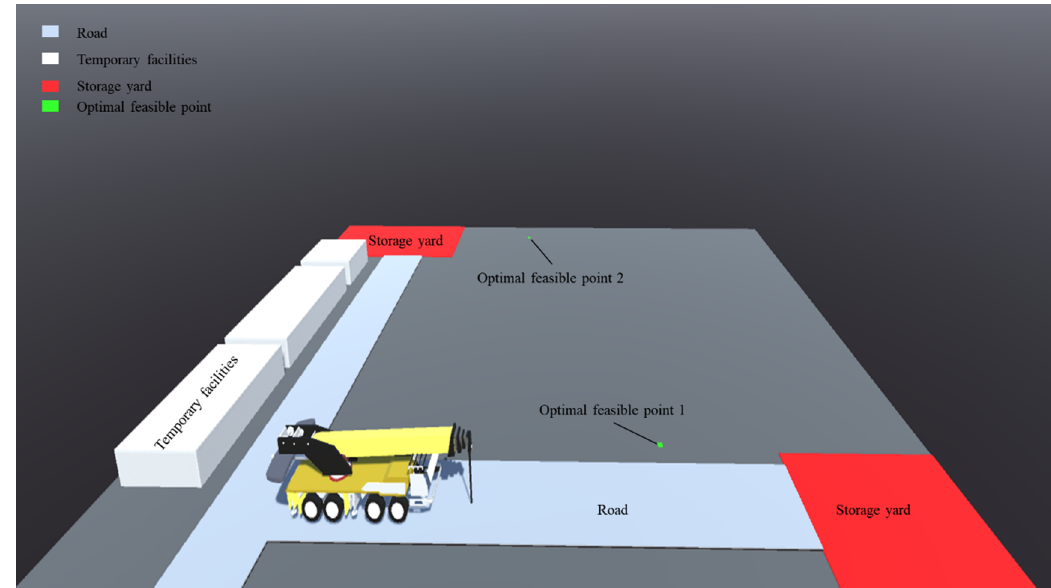
Figure 9. Optimal combination of feasible location points for crane QY100K-I.